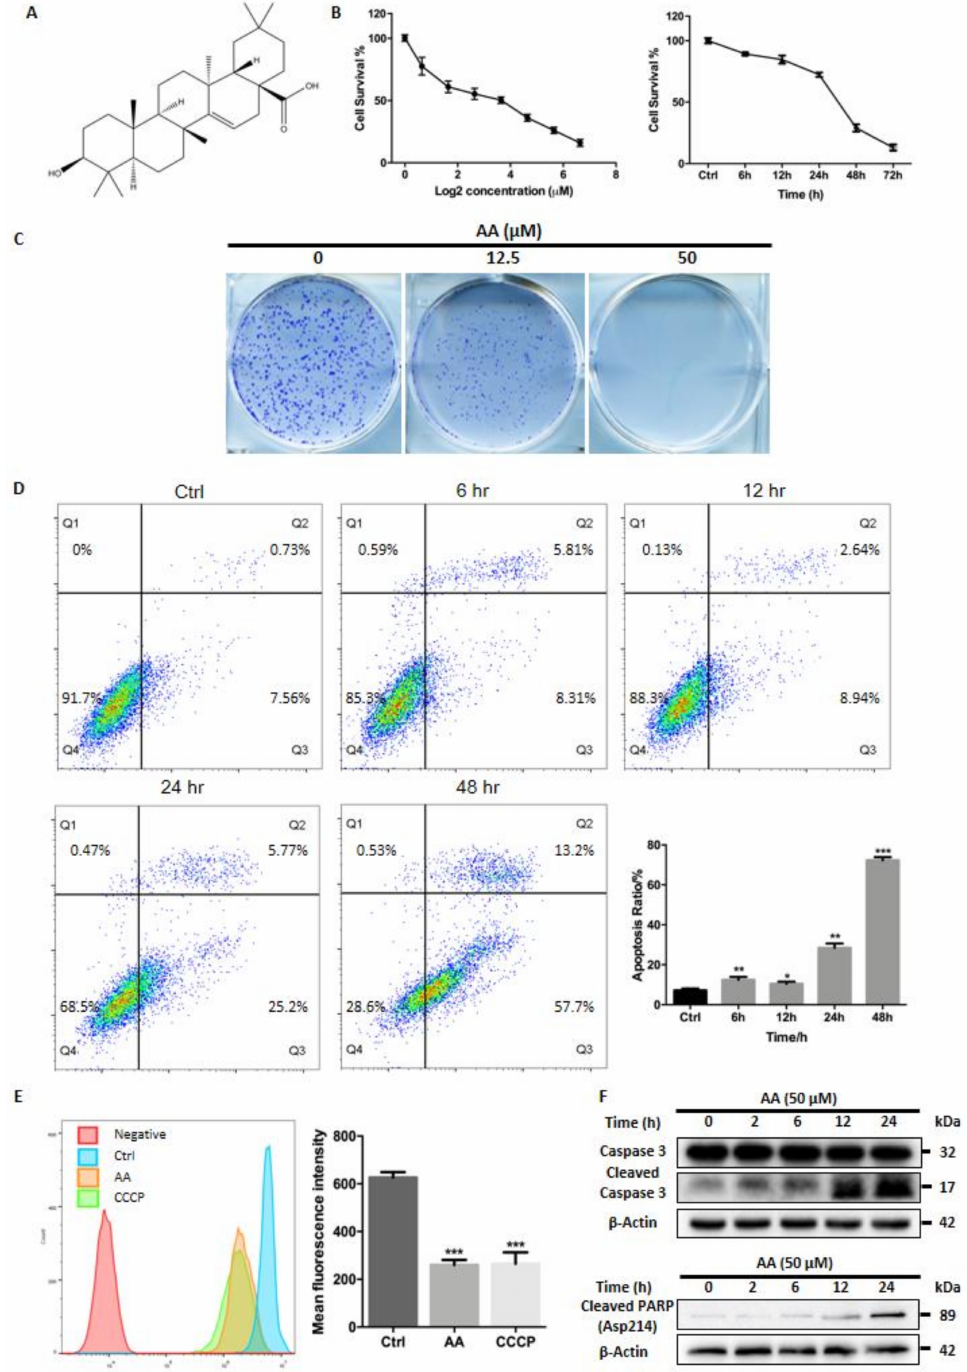
Figure 1. AA exhibited cytotoxic effects against HepG2 cells. ( A ) The molecular structure of aleuritolic acid is shown. ( B ) MTT assay shows that AA caused dose-dependent and time-dependent inhibitory effects on growth of HepG2 cells. The IC50 is 10.2 µ M. ( C ) Colony formation assays demonstrated a dose-dependent inhibitory effect of AA on colony formation of HepG2 cells. ( D ) AA treatment for different times induced early and late apoptosis in HepG2 cells. * p < 0.05, ** p < 0.01, *** p < 0.001, One-way ANOVA. ( E ) AA treatment depolarized mitochondria in HepG2 cells. The effect was comparable with CCCP, an uncoupler of mitochondrial respiration. *** p < 0.001, One-way ANOVA. ( F ) AA treatment caused a time-dependent accumulation of cleaved caspase-3 and cleaved PARP